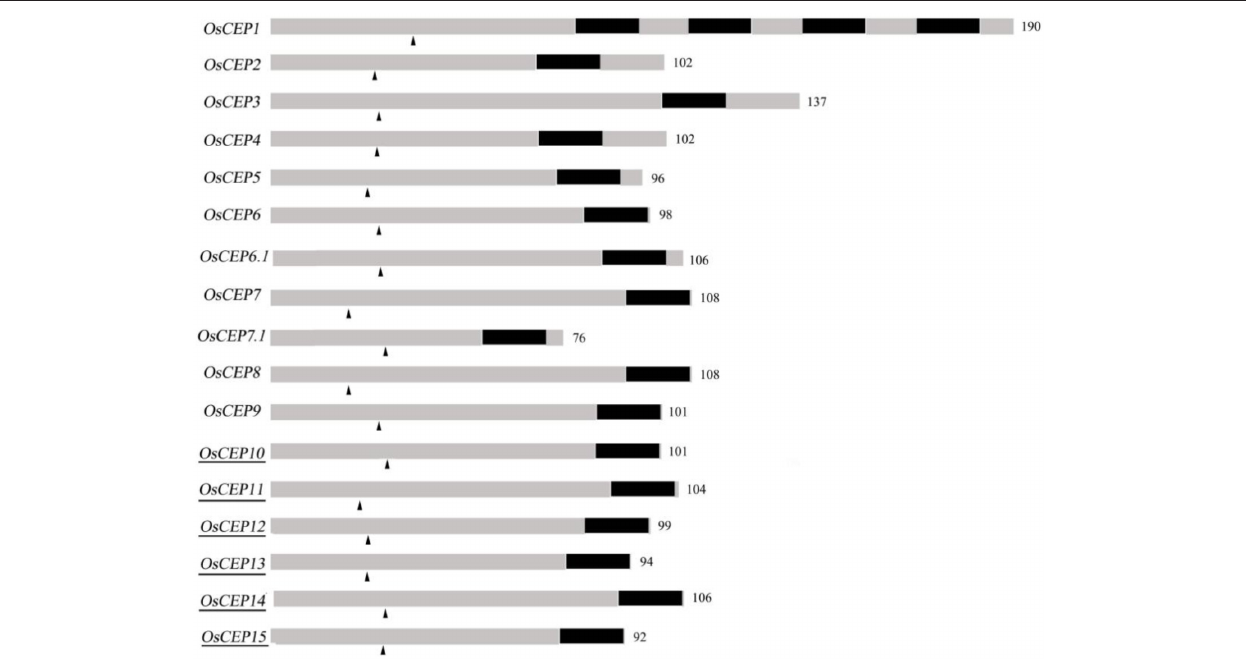
FIGURE 1 | Schematic representation of rice CEP genes. Numbers are number of amino acids of the full length protein; Dark part, CEP domain; arrowhead, predicted signal peptide cleavage site; underscore, new identified CEP